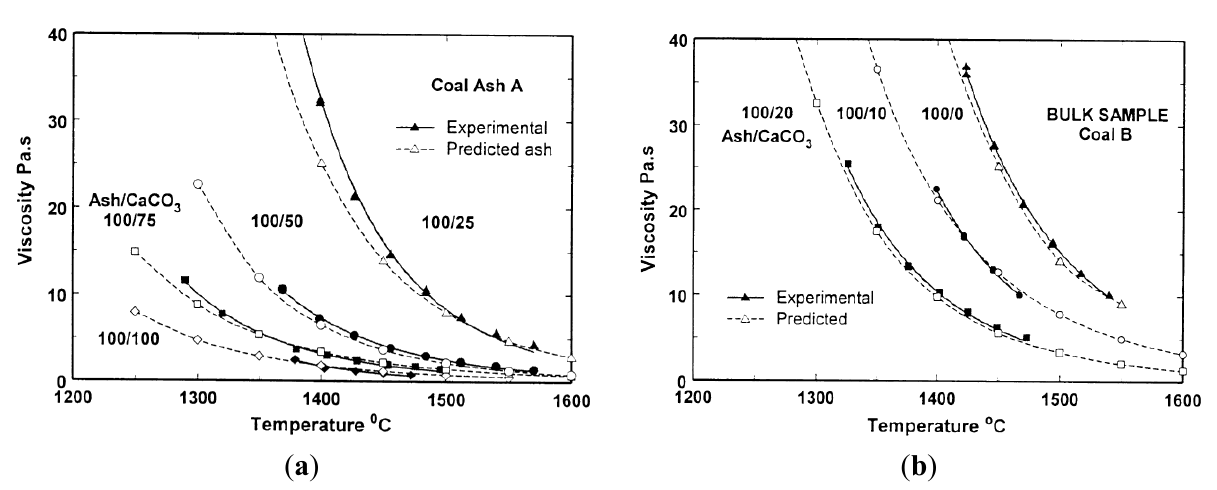
Figure 8. Viscosity versus temperature curves for selected coal ash at various flux addition ratios [26] . ( a ) Coal ash A; ( b ) Coal ash